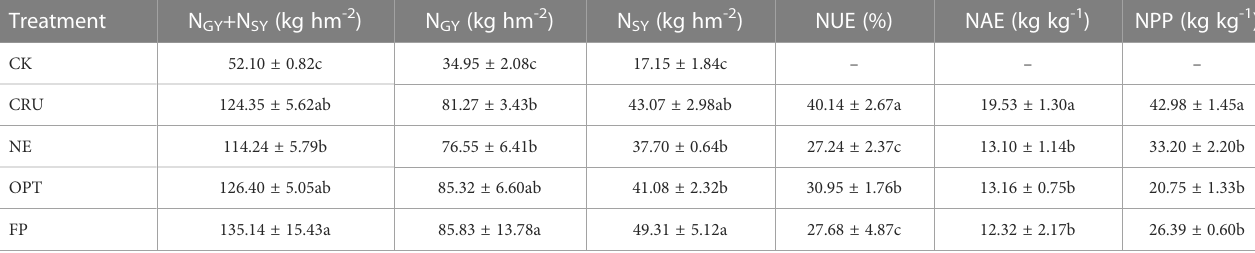
TABLE 4 Nitrogen uptake, Nutrient use Ef fi ciency (NUE), Nitrogen Agronomic Ef fi ciency (NAE), and Nitrogen Partial Productivity (NPP) under different nitrogen treatments during the paddy growing seasons. Treatment